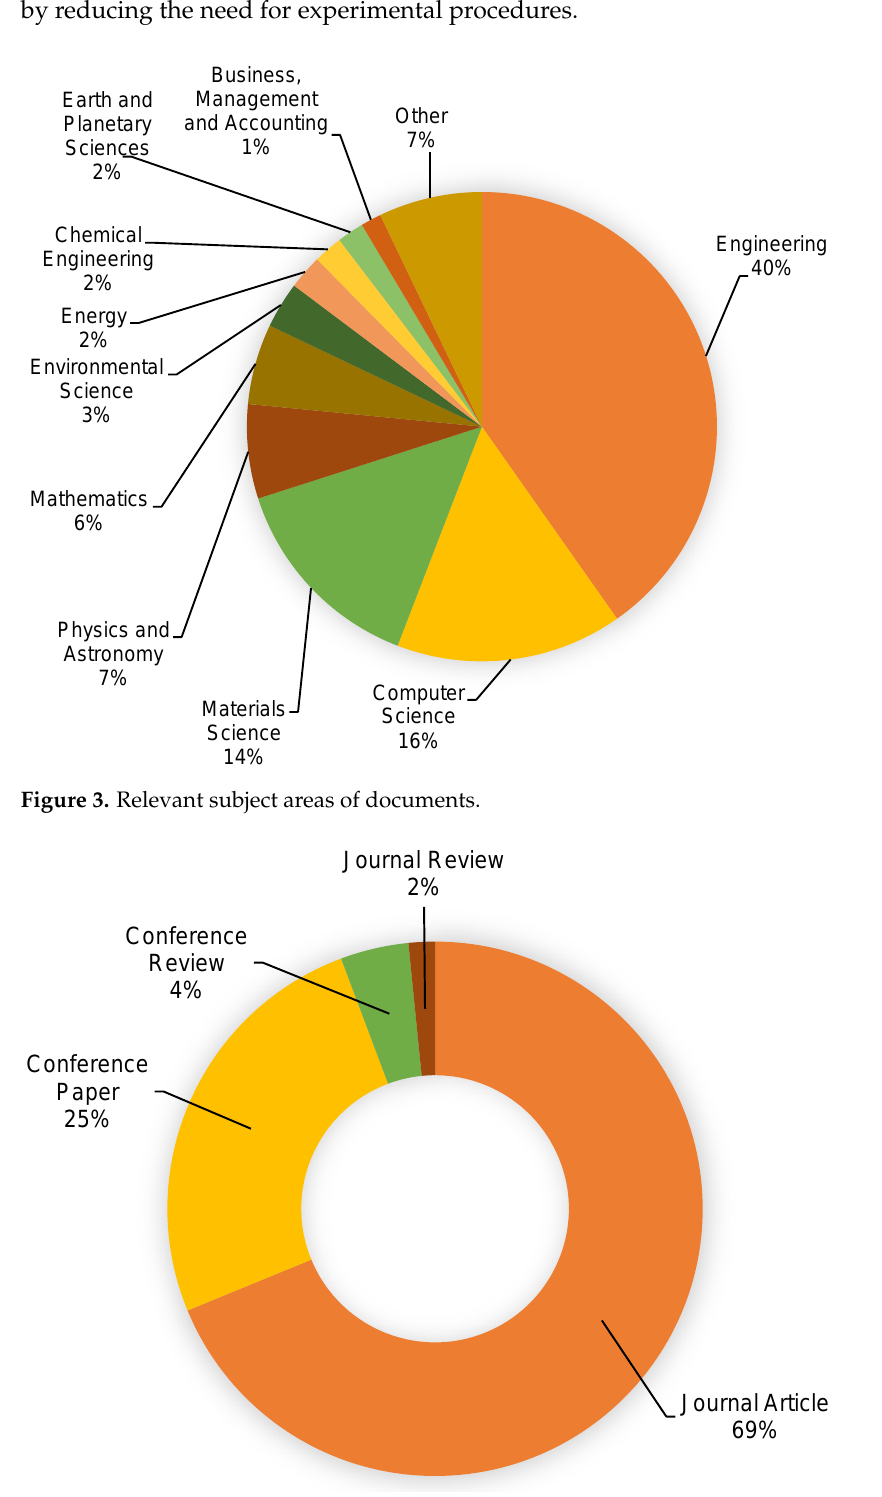
Figure 5. Annual publication trend for articles from 2001 to 2022 (May). 3.2. Publication Sources An evaluation of publication outlets (journals) was performed on the data using VOSviewer. A minimum of 15 papers per source was stipulated, and 13 of the 541 publi- cation sources satisfied this requirement. Table 1 displays the publishing outlets that re- leased at least 10 publications on ML for concrete up to May 2022, along with the number